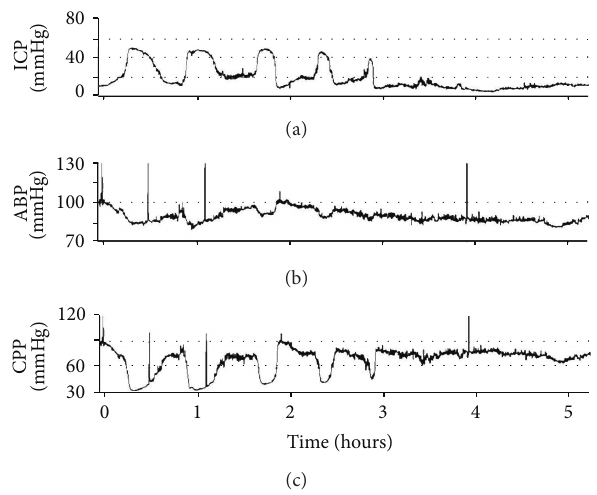
Figure 1: Case of a head injury patient with a highly unstable ICP, due to “plateau” waves. Details are in the text. ICP: intracranial pressure. ABP: arterial blood pressure. CPP: cerebral perfusion pressure.